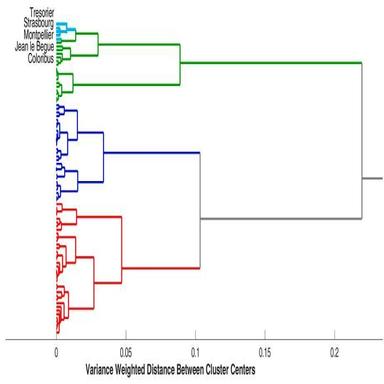
Brazilwood pinks in Ajuda Songbook are different from those found in books of hours. Thus, new recipes were tested (light blue). Principal component analysis applied to excitation and emission spectra of all the historical samples of brazilwood based paints: Ajuda Songbook (green), books of hours (blue) and books of hours (red), show that in these new formulations the chromophore colour is close but not yet there.